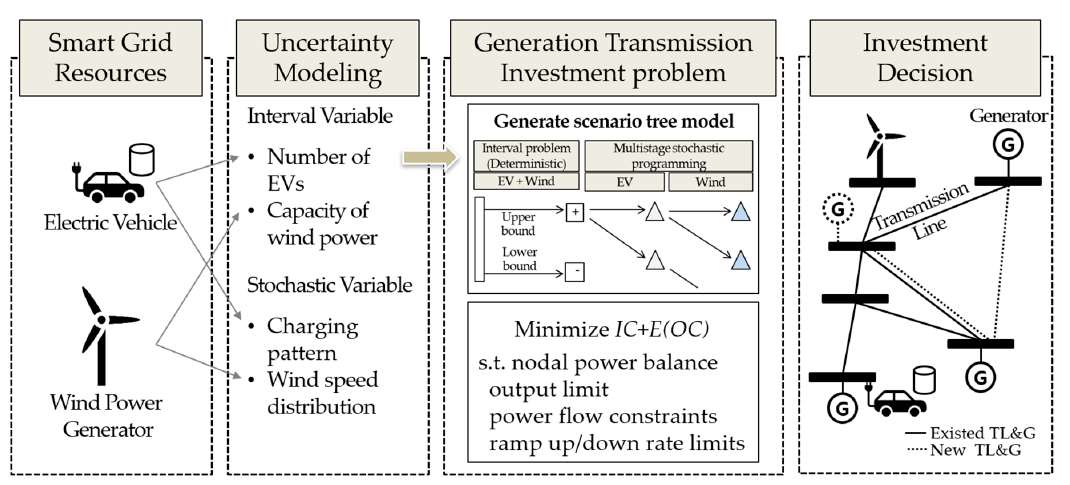
Figure 1. Schematic diagram of the proposed method.